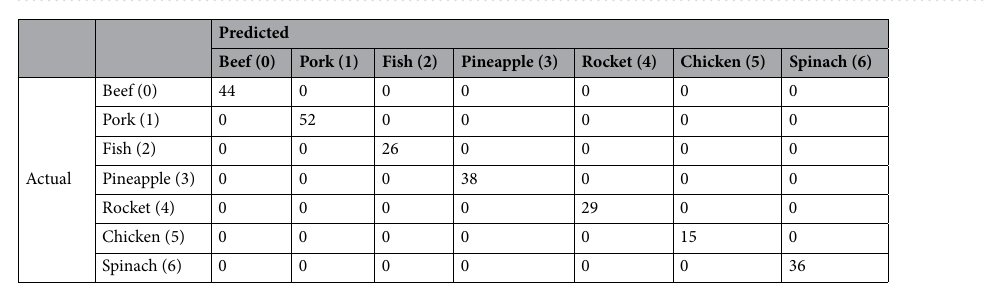
Table 1. Confusion matrix presenting the classification